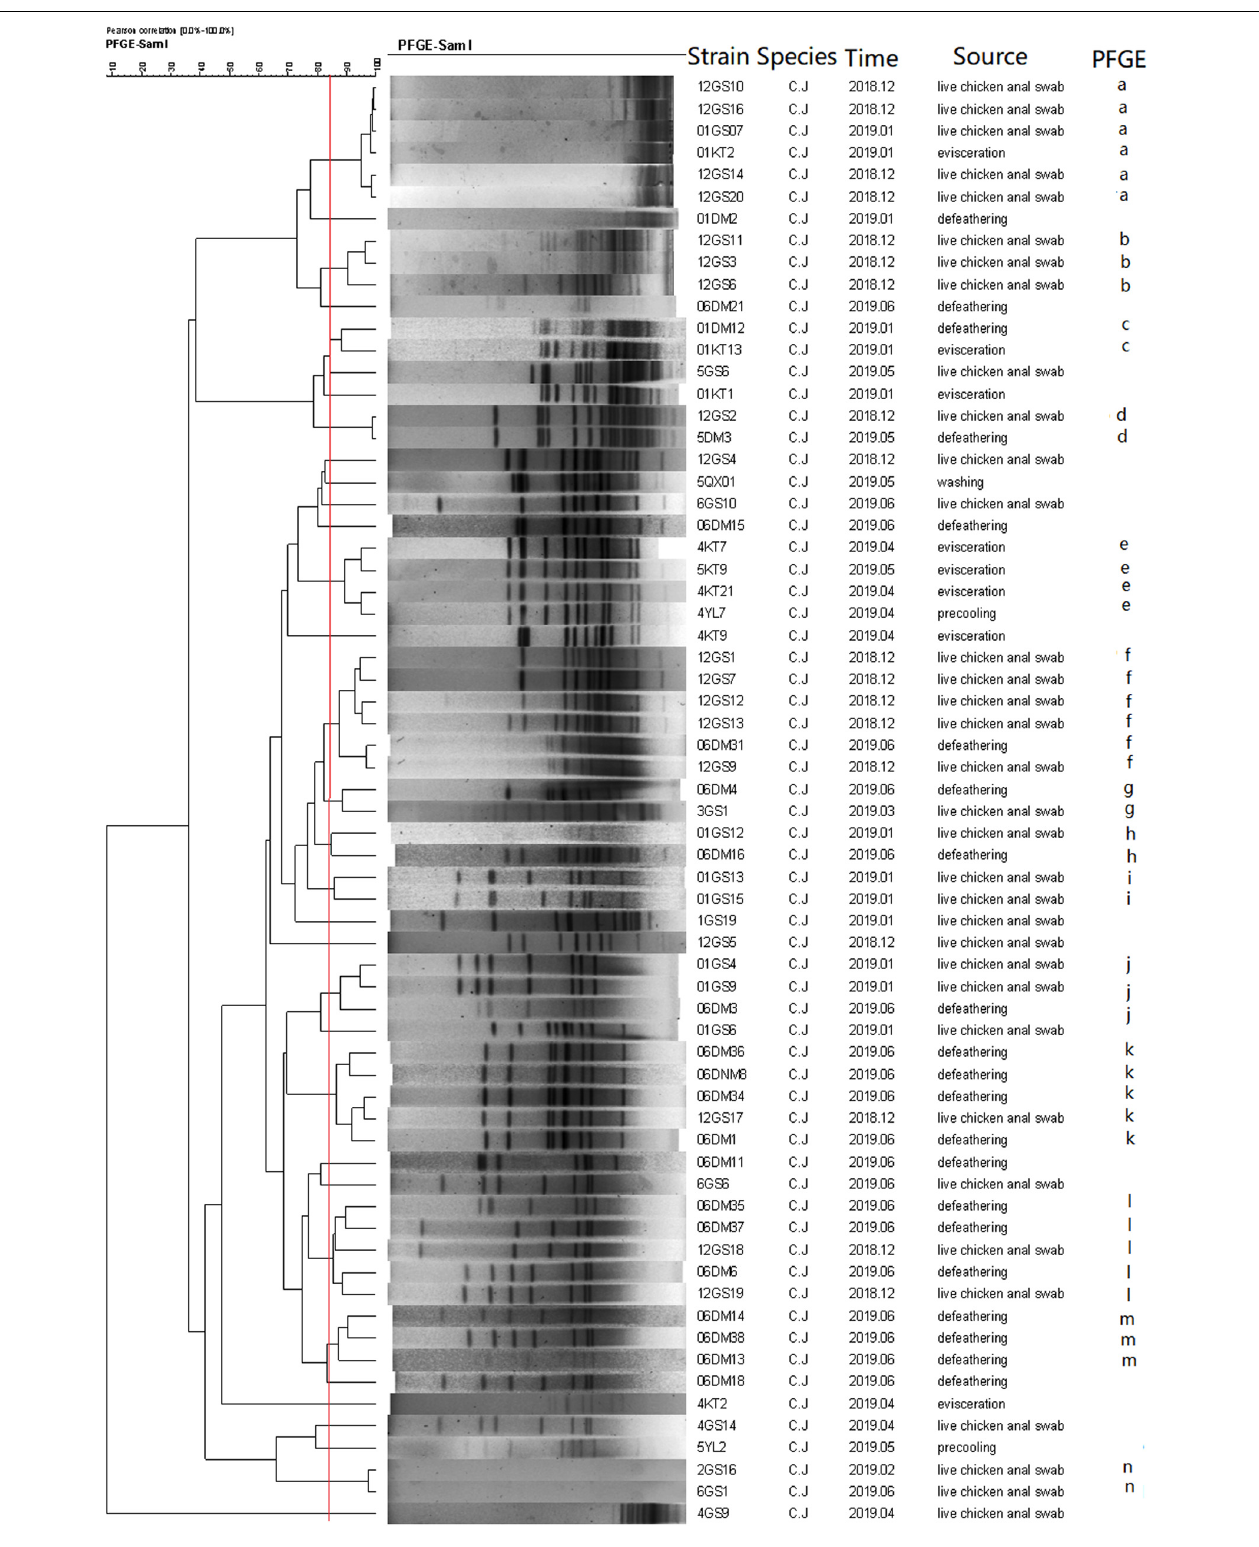
FIGURE 4 | Dendrogram of Sma I PFGE patterns of 66 C. jejuni isolates from five stages of the chicken slaughtering chain. (a–n) PFGE patterns.